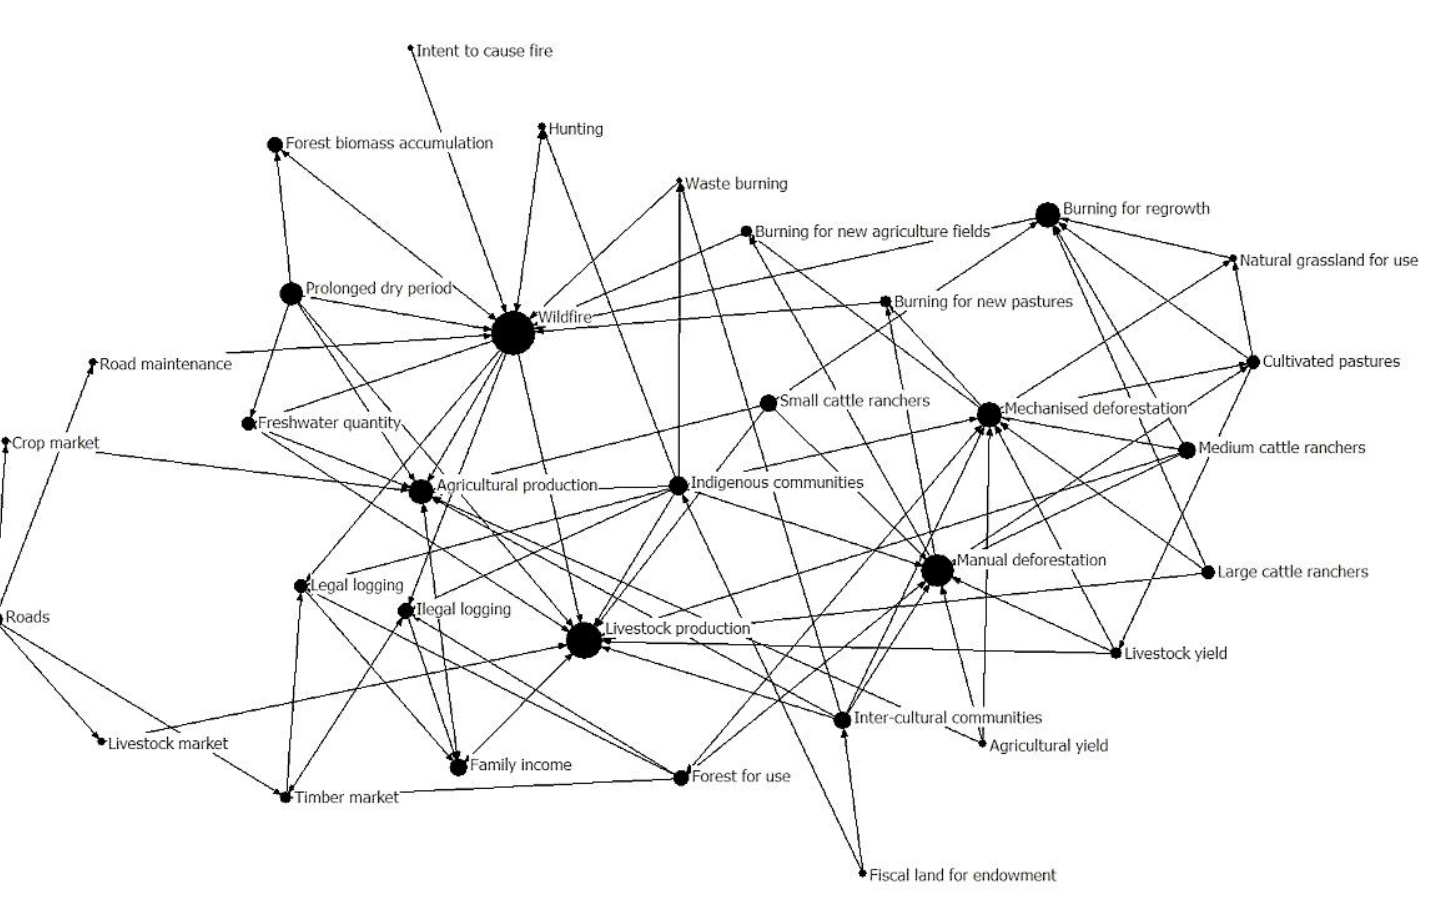
Fig. A6.1. Network showing the regional experts’ FCM. Variables with higher degree centrality are presented as larger nodes. Edge weights are not visualized to help